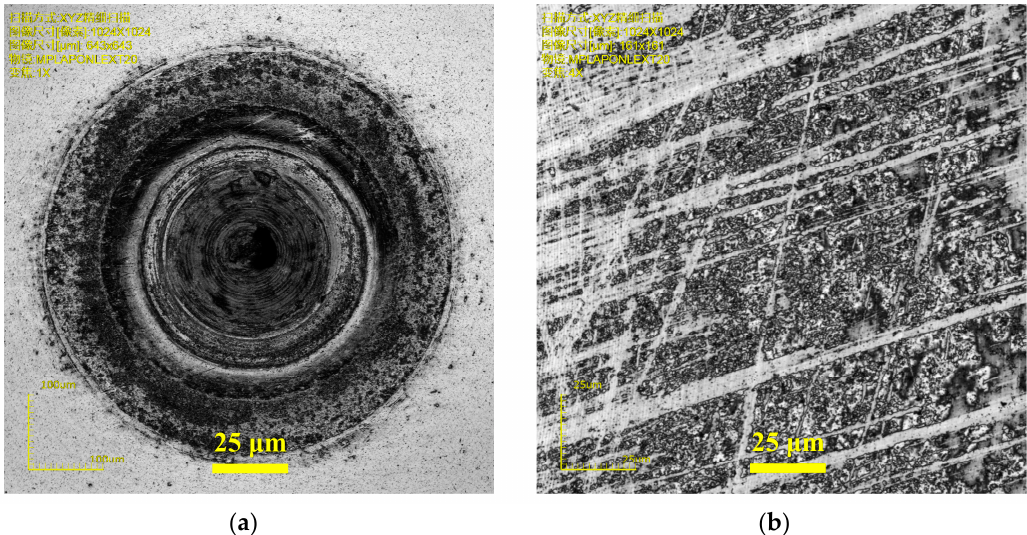
Figure 7. Laser microscope images of ( a ) thermal damage area under 20 W laser; ( b ) high-temp chip stuck on the machined surface.